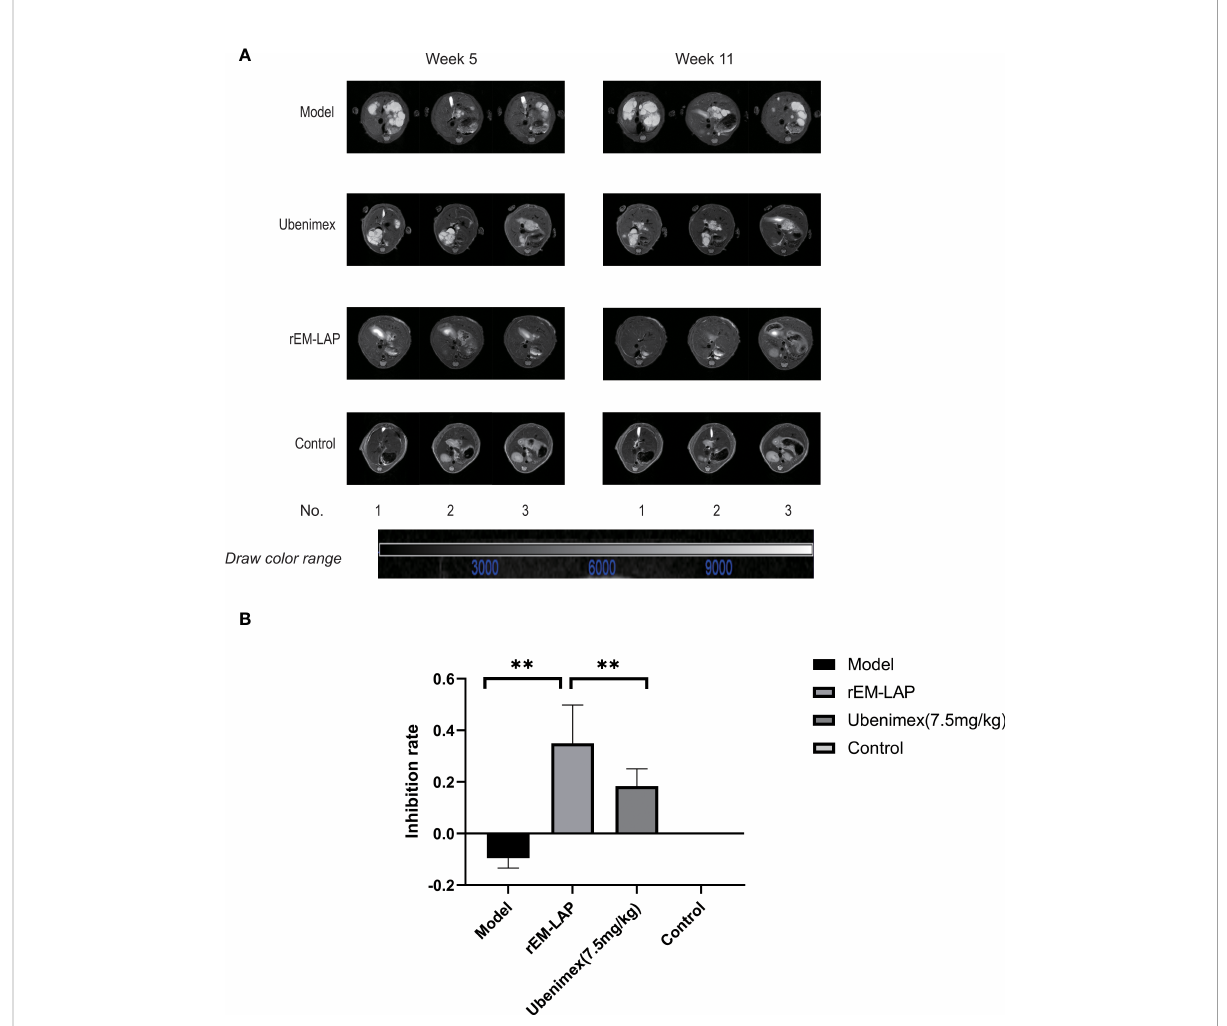
FIGURE 2 Both rEM-LAP and Ubenimex inhibited cyst growth in livers of mice infected with E. multilocularis protoscoleces. (A) MRI of the abdomens of mice treated with rEM-LAP IOCV and Ubenimex (7.5 mg/kg) I.P for 6-10 weeks as described in Materials and Methods. (B) The cyst growth inhibition rate (IR%) calculated from MRI results.